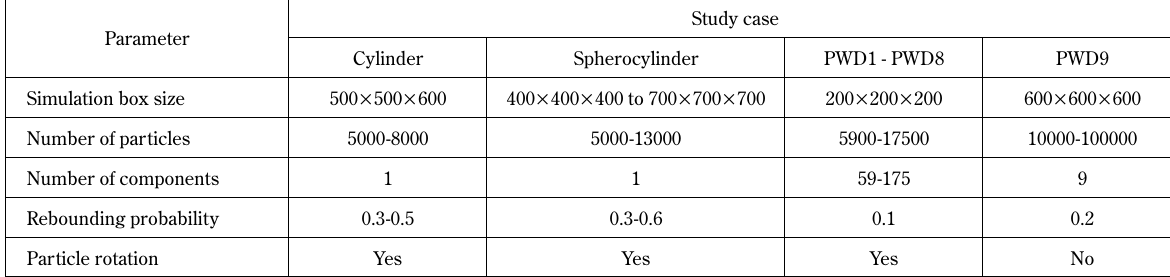
Table 3 Summary of simulation conditions for cylinders, spherocylinders and powders